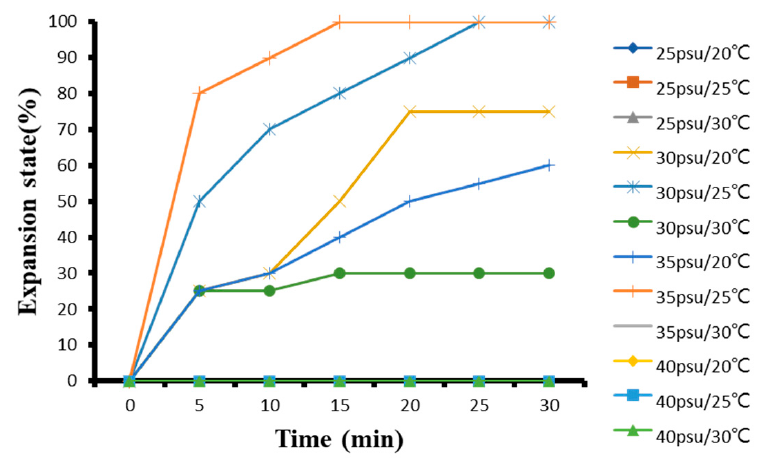
Figure 3. The influence of different temperature and salinity environment on the adaptability of G. G. columna columna.